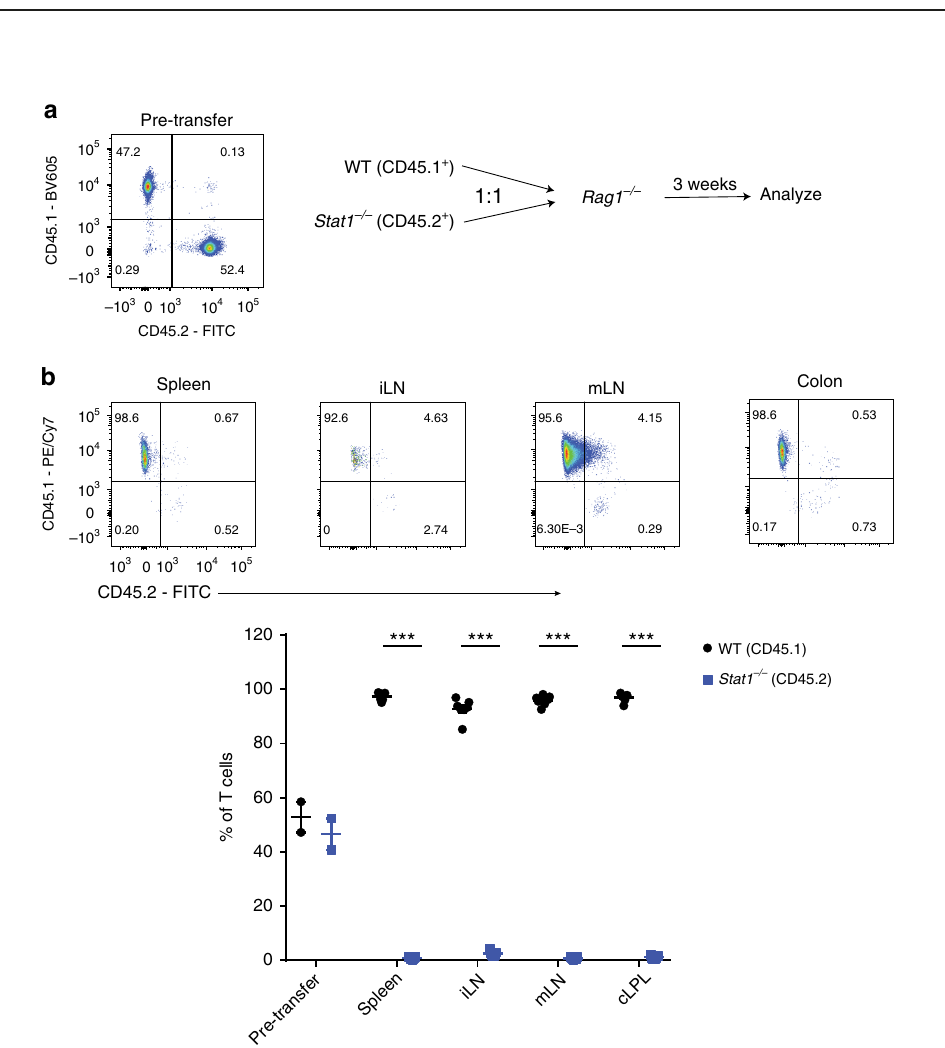
Fig. 4 The defective expansion of Stat1 − / − T cells is cell-intrinsic. WT (CD45.1 + ) or Stat1 − / − (CD45.2 + ) unfractionated CD4 + T cells were injected i.p. at a 1:1 ratio (0.8 – 1 × 10 6 /type) into Rag1 − / − mice. a Schematic of experiment and representative plot of cells injected. b Representative images of CD45.1 + vs CD45.2 + cells (gated on live CD45 + CD3 ε + CD4 + T cells) from various organs followed by their mean frequencies ± SEM. Data is pooled from two independent experiments, with each point representing an individual mouse. *** p < 0.001 by two-tailed Mann – Whitney test. Accompanied